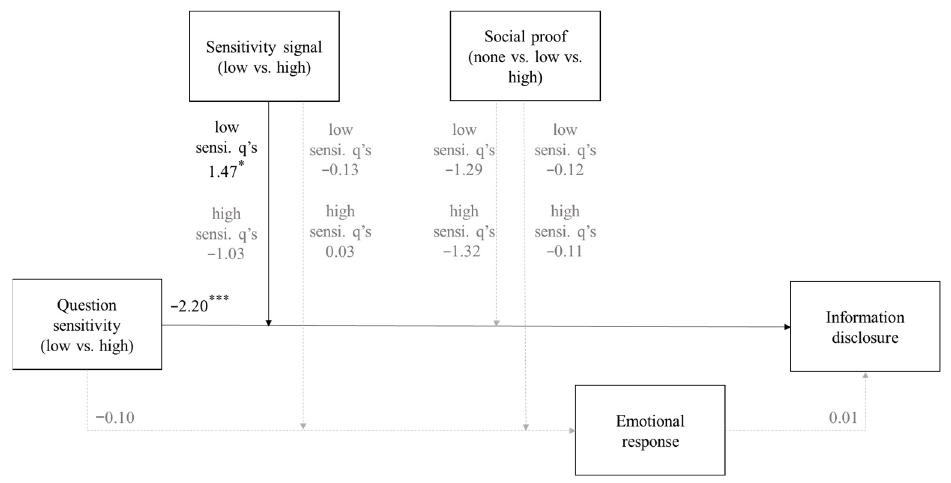
Figure 4. Validated Research Model. * significant at 0.05 level; *** = significant at 0.001 level.